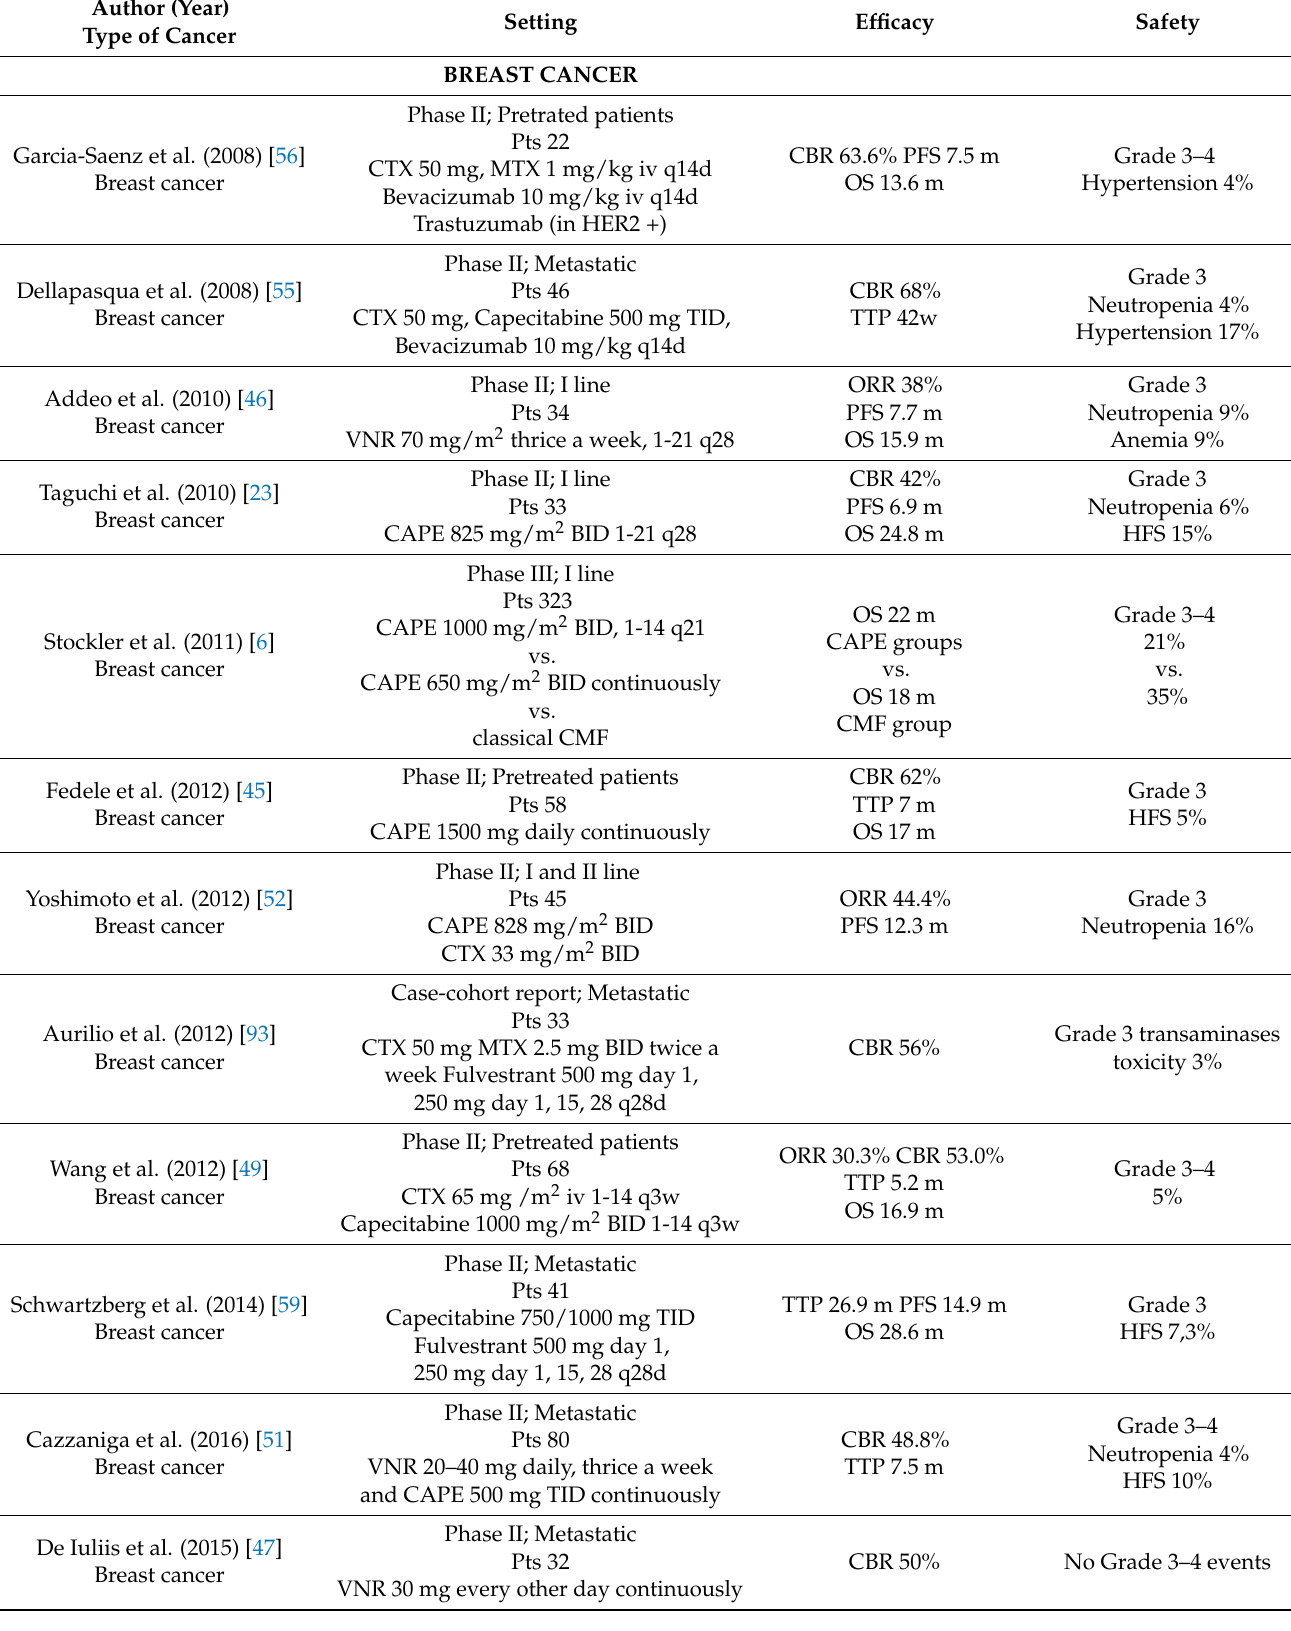
Table 2. Summary of results of trials using mCHT in classical cancers (breast, lung,